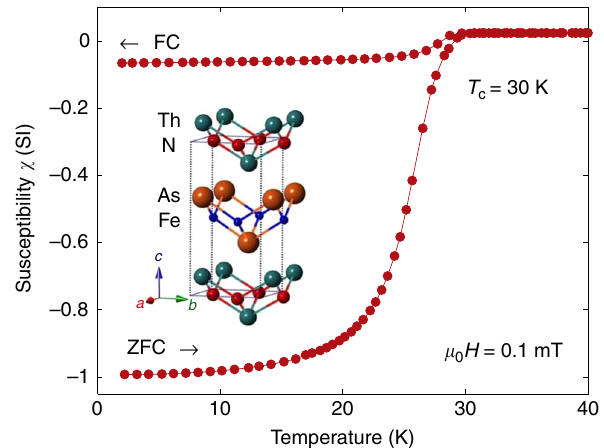
→→ Fig. 1 Magnetic susceptibility of ThFeAsN. Temperature dependence of the zero fi eld-cooled (ZFC) and fi eld-cooled (FC) dc susceptibility measured at μ 0 H = 0.1 mT. The sample shows a sizable diamagnetic response and T c = 30 K. Inset: structure of ThFeAsN showing the ThN and FeAs planes (adapted from Wang et al. 18